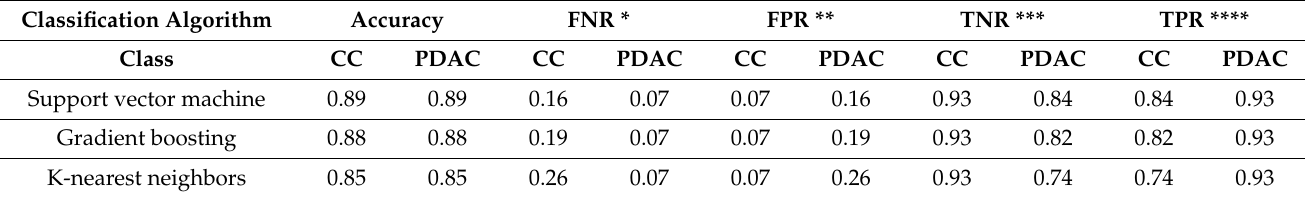
Table 3. Performance metrics for the binary classification task of differentiating between pancreatic ductal adenocarcinoma and cholangiocarcinoma using gradient boosting, support vector machine, and k-nearest neighbors on the balanced